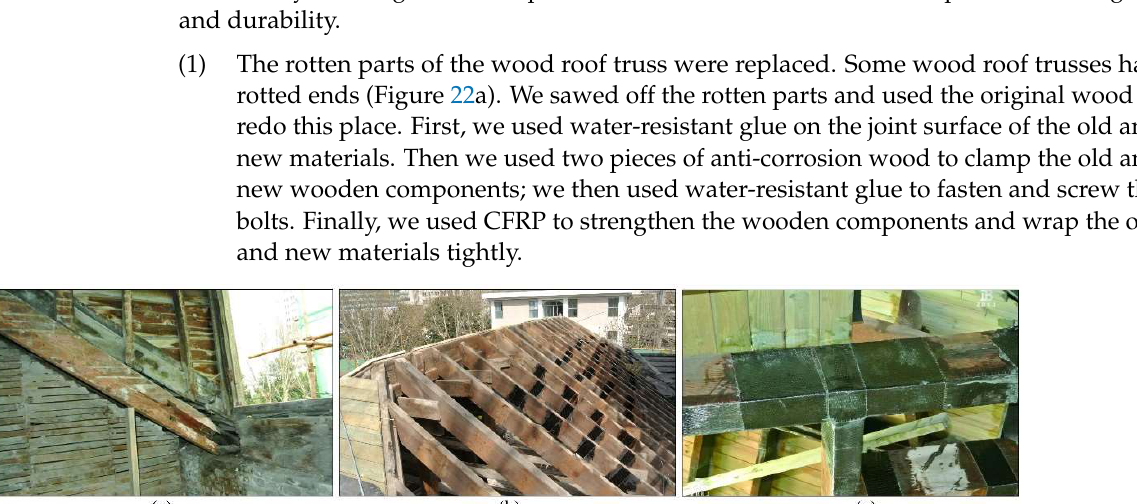
Figure 21. Wood joists and wood stair strengthening (source: author). ( a ) Broken wood joists ( b ) Wood joists strengthening ( c ) Stair strengthening.